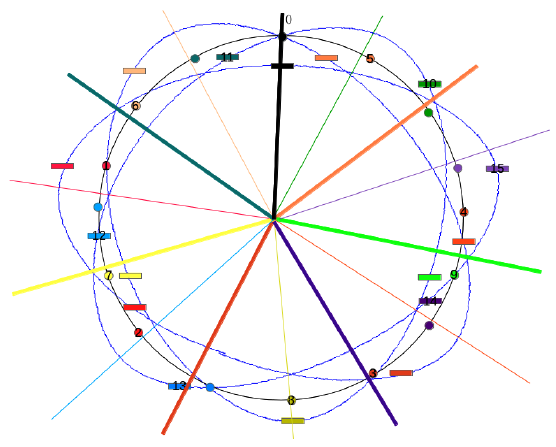
Figure 8. A timestamp breakdown of the 3:4:7 resonance in the Earth-centered inertial frame. Each timestamp includes a moon (small solid circle) and vehicle (rectangle). The moon and vehicle are color-matched, and each timestamp sequentially numbered. The grey circular line (on which the small circles are found) represents the trajectory of the moon, and the blue irregular line represents the trajectory of the vehicle. Starting at the top (black,0), both the moon and vehicle trace three earth-orbits before returning to the black state. The color-coordinated numerical sequence illustrates each quarter of the four lunar-orbits. The radial lines approximate the positions at which the vehicle is at inferior (thick lines) and superior (thin lines) locations relative to the moon; together, they illustrate the seven cycles in the rotating frame. The radial lines are color-coded to be close to the colors at a nearby time-stamp.